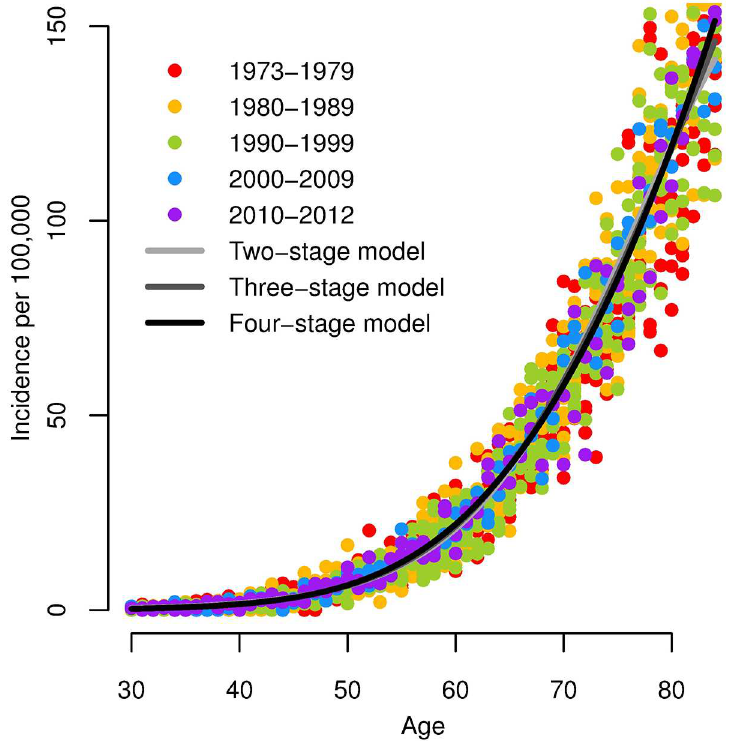
Fig 3. Pancreatic cancer incidence and best-fit MSCE models. Incidenceof pancreatic cancer in men per 100,000(SEER 9, 1973–2012), and best-fit two-, three-, and four-stage clonalexpansionmodel hazards. Note that the three model hazardslargely